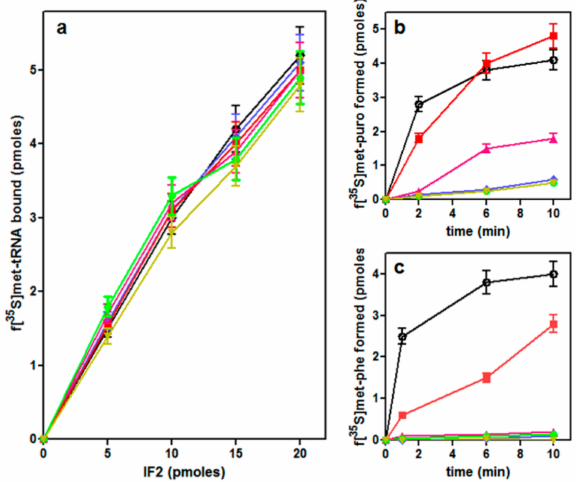
Figure 5. Activity of wtIF2 and IF2His301 mutants in performing individual functions of the translation initiation pathway. ( a ) Binding of fMet-tRNA to mRNA-programmed 30S ribosomal subunits to